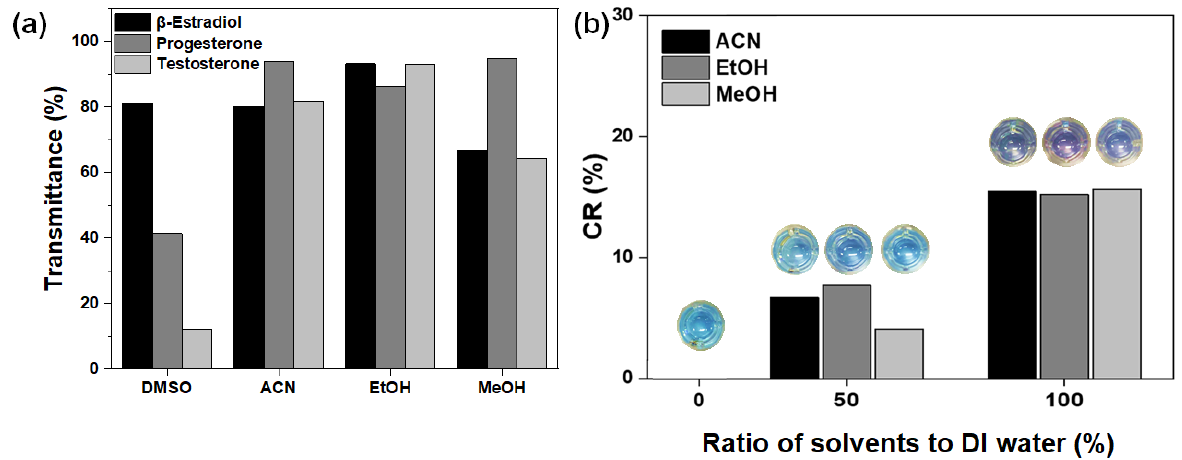
Figure 3. ( a ) Solubility test of sex steroid hormones in solvent medium (Dimethyl sulfoxide (DMSO), acetonitrile (ACN), ethanol (EtOH), methanol (MeOH)). ( b ) Colorimetric response ( CR ) of PDA when adding candidate solvent to the medium. Inset: photograph of the PDA solution after adding solvent to the medium.